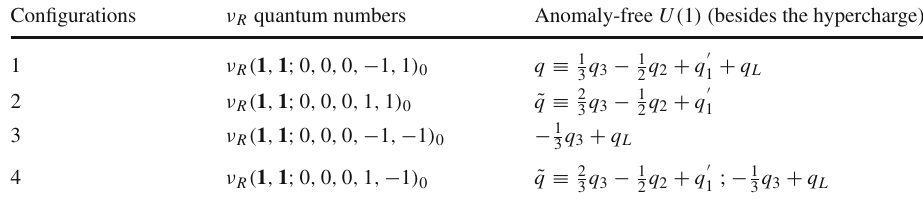
Table 4 Anomaly-free U ( 1 ) in Configurations ν R quantum numbers Anomaly-free U ( 1 ) (besides the configurations with right-handed neutrinos (model A)